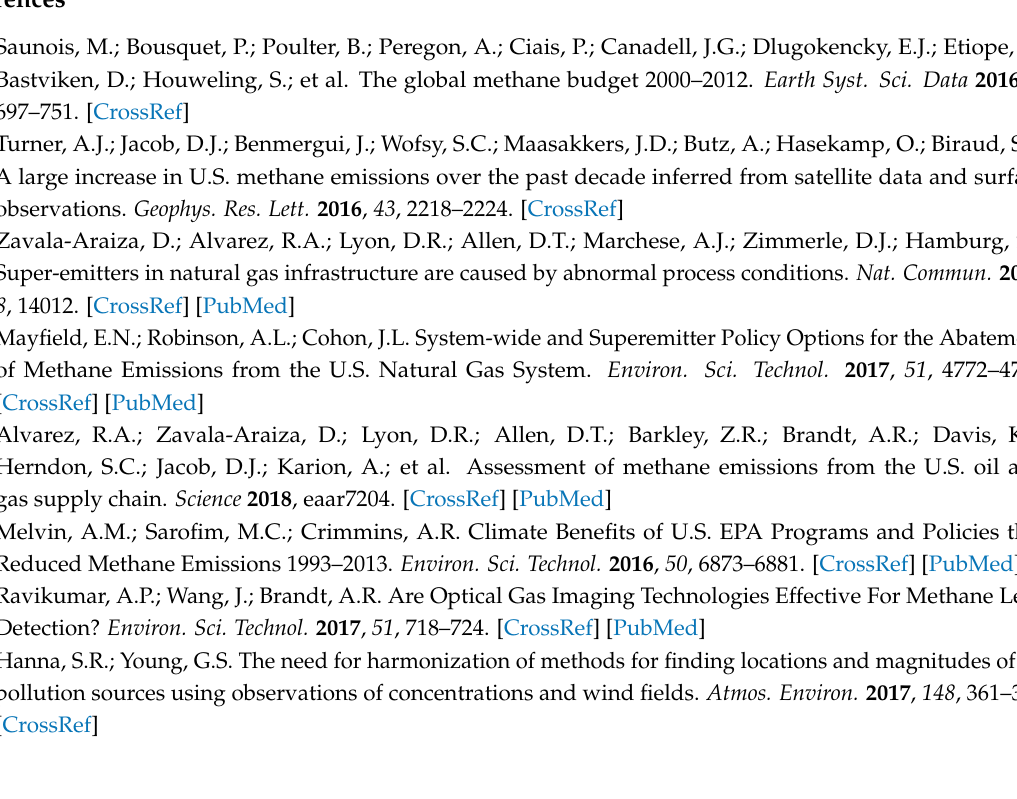
Figure S1: field test locations, Figure S2: all METEC location results, Figure S3: all METEC rotated flux results, Figure S4: all METEC skewness